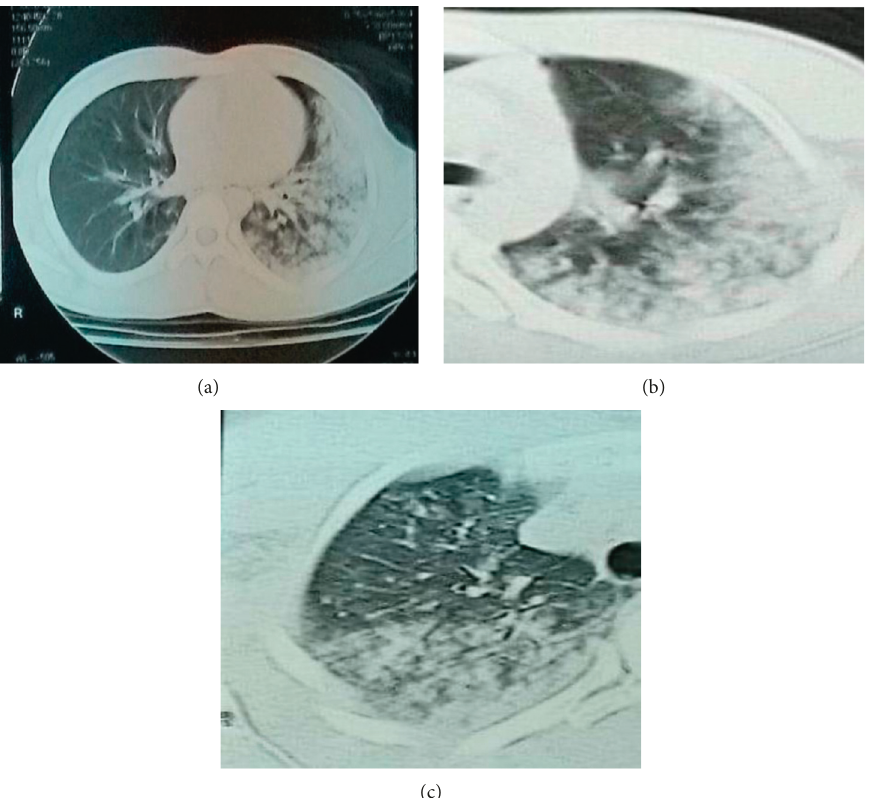
Figure 4: 3 CT scan images classifying lung contusions. (a) Total areas on the left lung filled with lesions (score 4); (b) lesions filling the whole lateral and part of medial lung (score 3); (c) contusion not filling all the lateral nor the medial areas (score